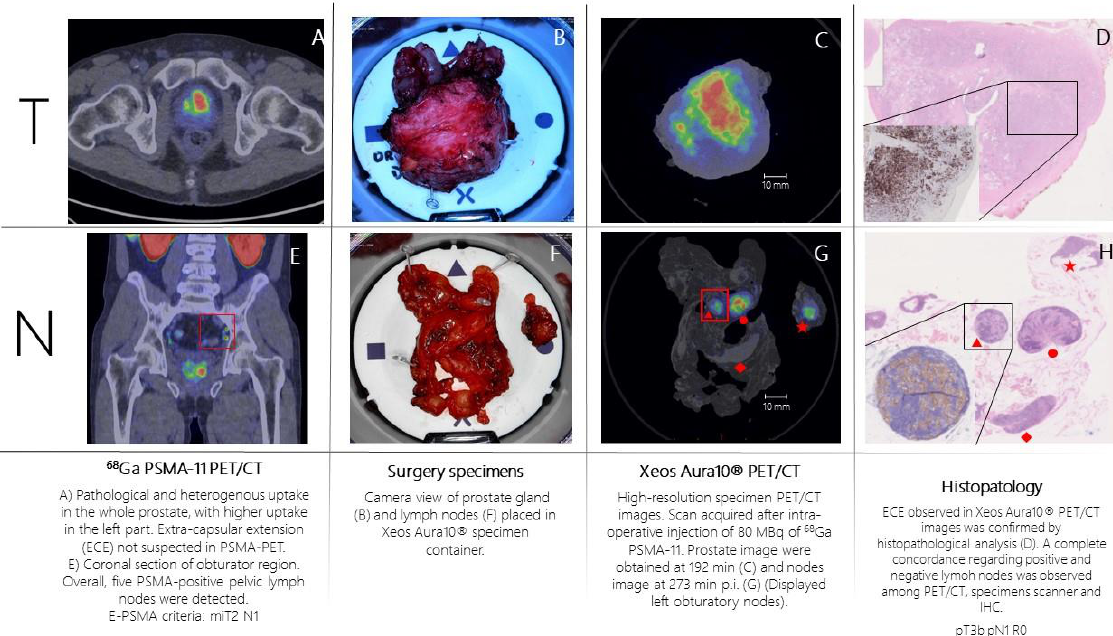
Figure 2. Patient 1 (prostate cancer): 68 Ga-PSMA-11 whole-body PET/CT image showed pathological PSMA uptake (high expression, E-PSMA Visual Score = 3) in the prostate ( A ) and in five pelvic lymph nodes ( E ). This figure also represented surgery specimen’s macro pictures ( B , F ), high-resolution specimen PET/CT images ( C , G ) and histopathological analysis in the specimens where immunohistochemical analysis (PSMA staining) was performed (see correspondence between red shapes in subfigures ( G , H )). Red shapes explanation same as in Figure 1.